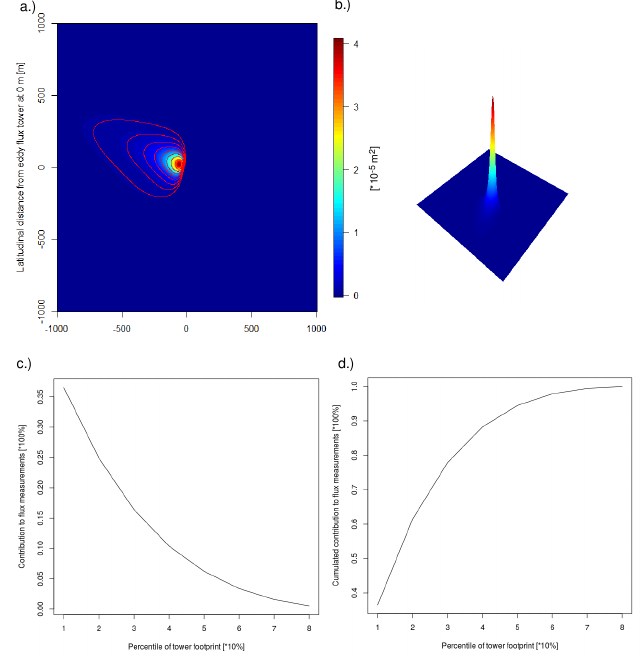
Figure 2. Derivation of a two-dimensional eddy covariance (EC) footprint with a sampling rate of 30 min average of the 29th of June 2016. ( a ) Extent of footprint from the EC system (at 0;0 m) in x and y directions, representing longitudinal and latitudinal distance [m] respectively; colors indicate the weighted PDF function [*10 − 5 m 2 ]. ( b ) Three-dimensional distribution with weighted PDF function in z direction [*10 − 5 m 2 ] of the same tower, ( c ) contributing flux [%] for percentiles of tower area, and ( d ) cumulated flux